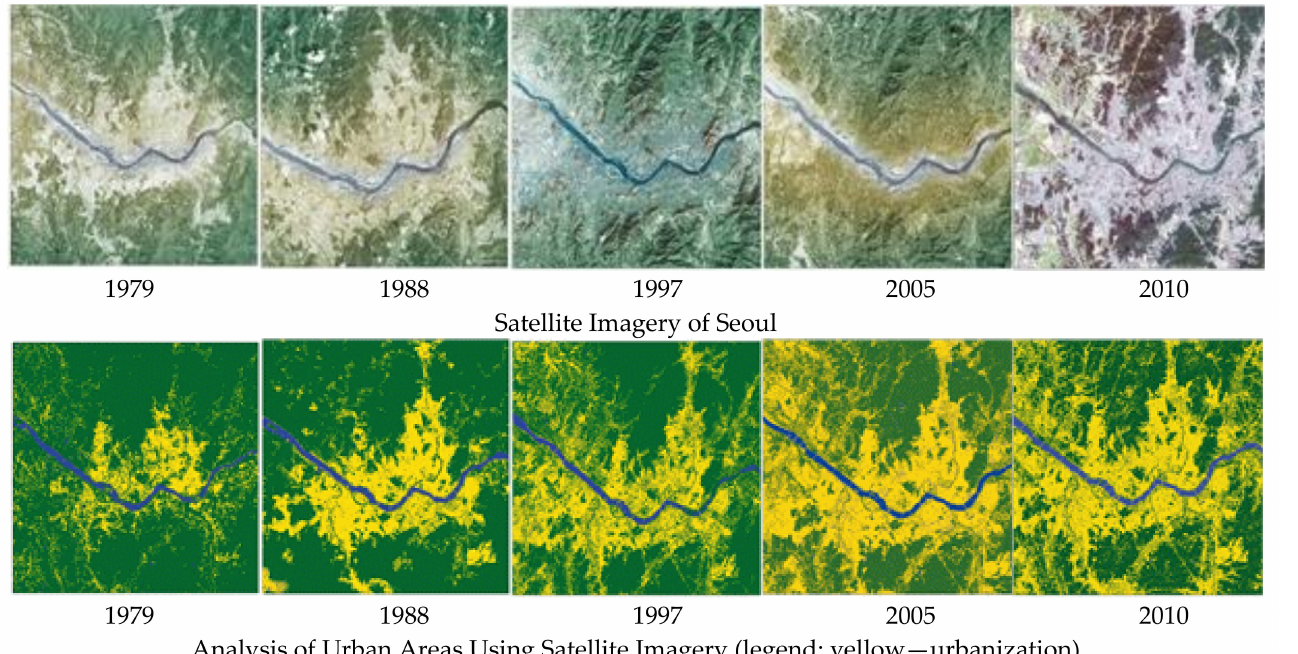
Figure 4. Change in urban areas in Seoul